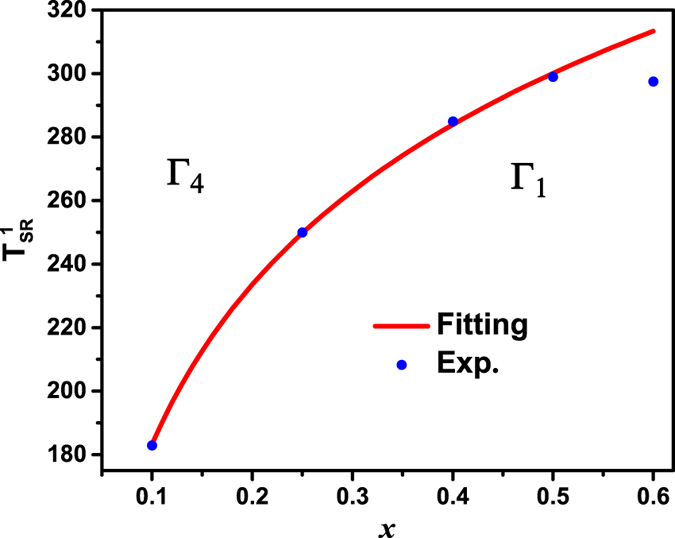

as a function of
x in TbFe1−xMnxO3 system.The solid line is the fitting of Eq. (1).